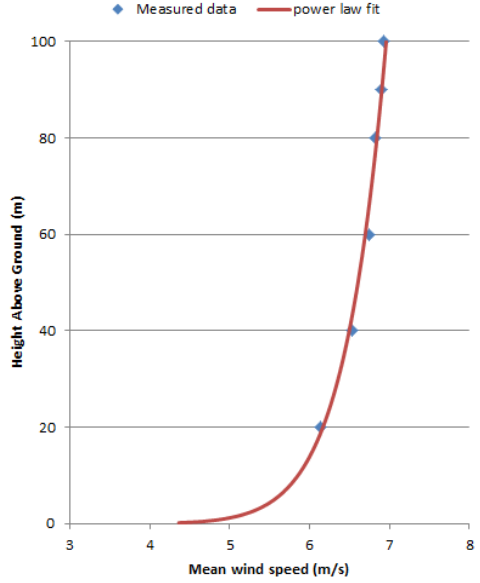
Figure 3. Vertical mean wind shear profile of E1004 using 129,950 samples and power low fit profile extrapolated to 10